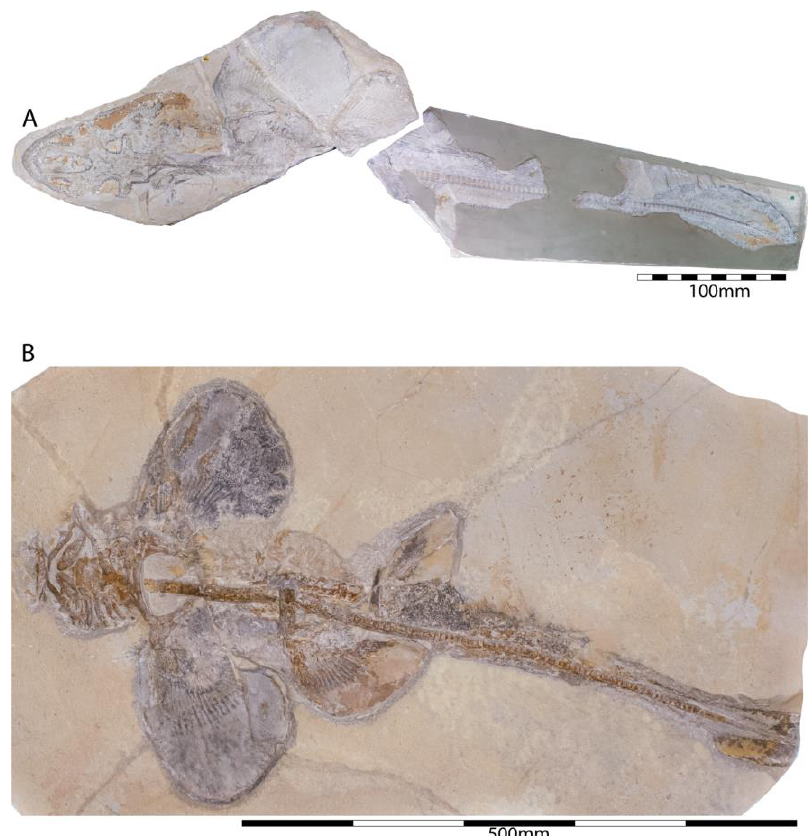
Figure 30. † Protospinax annectans Woodward, 1918 [232]. ( A ) Holotype specimen (NHMUK PV P 8775) from the lower Tithonian from Solnhofen. ( B ) Holomorphic specimen preserved in ventral view (SNSB-BSPG 1963 I 19) from the lower Tithonian of Eichstätt.